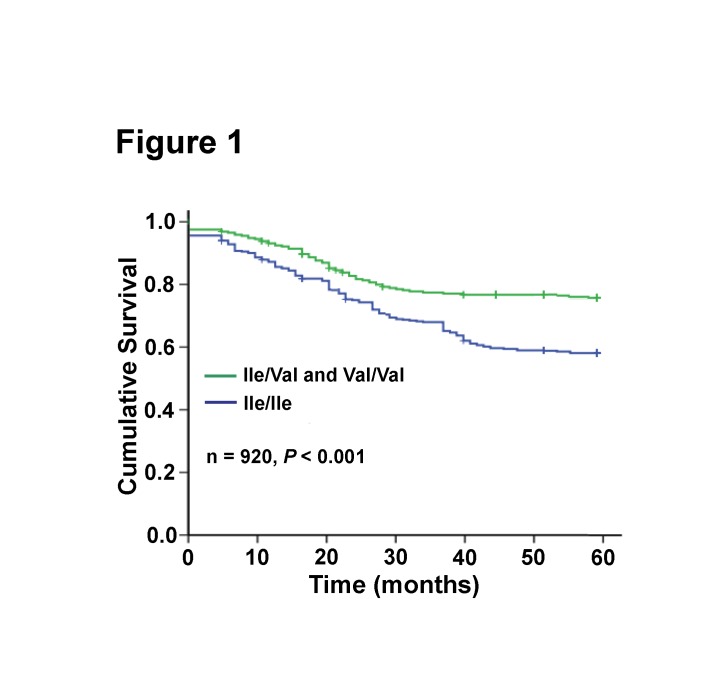
Kaplan-Meier analysis of DFS among patients with GSTP1
Ile105Val genotypes treated with a CTX-based regimen.